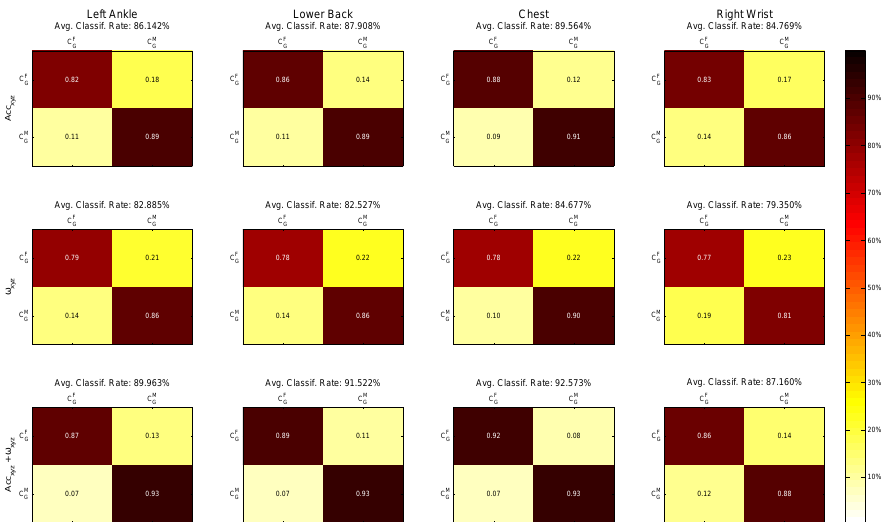
Figure 3. Confusion matrices of gender classification computed with 10-fold cross-validation. Each column presents sensor position (left to right): left ankle, lower back, chest and right wrist. Each row presents feature sets used for classification (top to bottom): 3D accelerations (26 features), 3D angular velocities (26 features) and 6D accelerations and angular velocities (50 features). Classes: C F = gender female; C M = gender male. G G